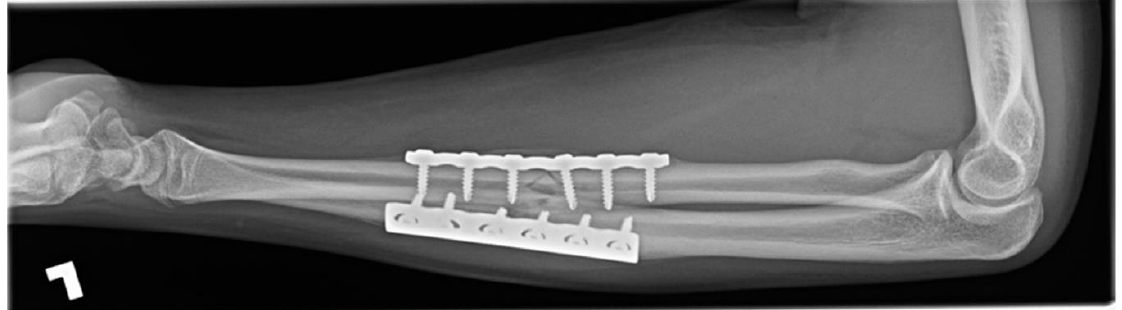
Figure 3. Twelve-week radiograph of an operatively treated both-bones forearm fracture in a pediatric electronic cigarette user. The ulna is healed, but the radius is not.